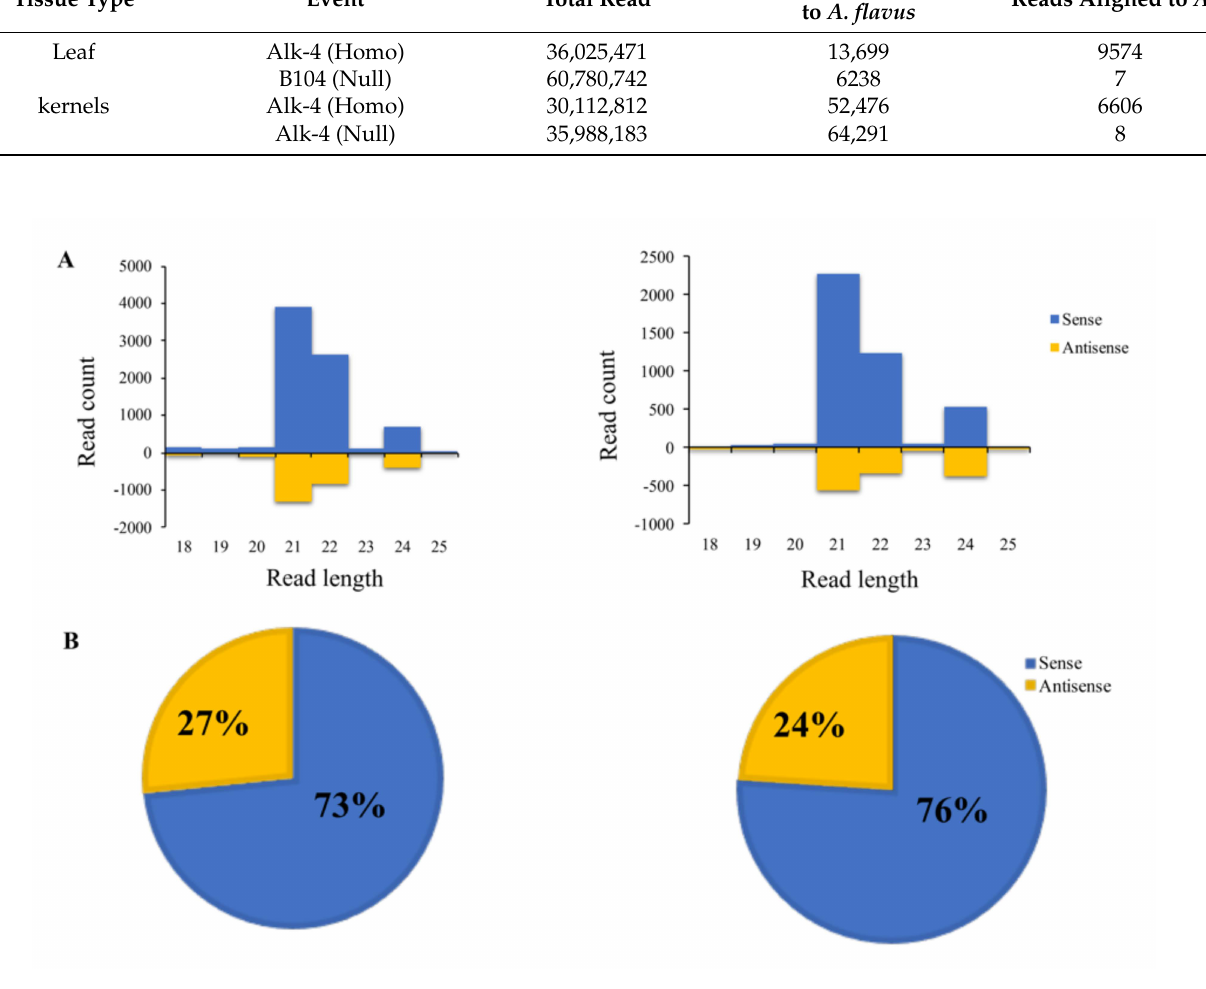
Table 5. Number of small RNA reads in leaf and immature kernels tissues of transgenic and non-transgenic maize lines. Tissue Type